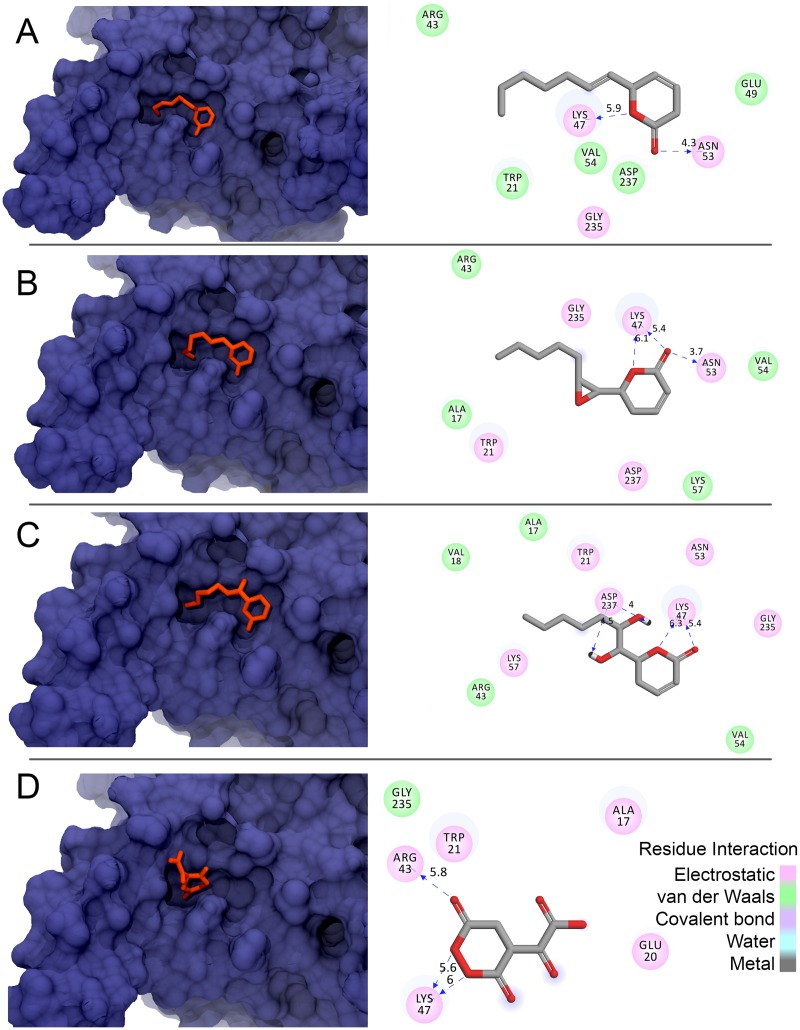
Molecular surface representation of PbICL and the three-dimensional structures of A) 1, B) 3, C) 4, and D) isocitrate (native ligand) in the PbICL binding pocket and key interactions of PbICL with the best conformation (mode 1) of each compound (orange).Ligplots of the compounds in binding pocket of PbICL. Pink circles indicate residues involved in hydrogen-bond polar or charged interactions; green circles indicate residues involved in van der Waals interactions. Dashed lines represent stronger interactions. The PbICL residues that interact with the compounds are shown, and the dashed lines represent stronger interactions. Oxygen is colored red. The structures of the compounds shown refer to the lowest Fscore obtained in mode 1 from the docking simulations with AutoDock Vina. The grid was defined considering only the region of the PbICL site using sizex = sizey = sizez = 20 Å, centerx = 21.37 Å, centerx = 1.14 Å, and centerz = 10.83 Å.